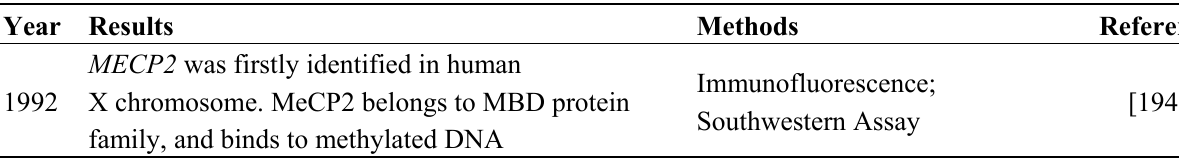
Table 2. Methods used in MECP2 studies along with the historic timeline of research